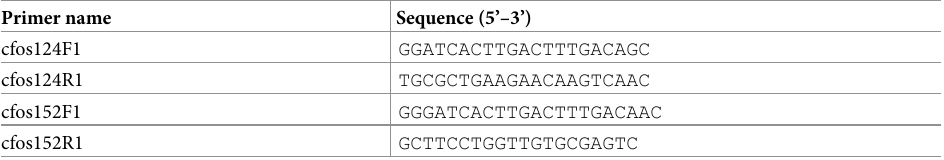
Table 1. Primers for molecular